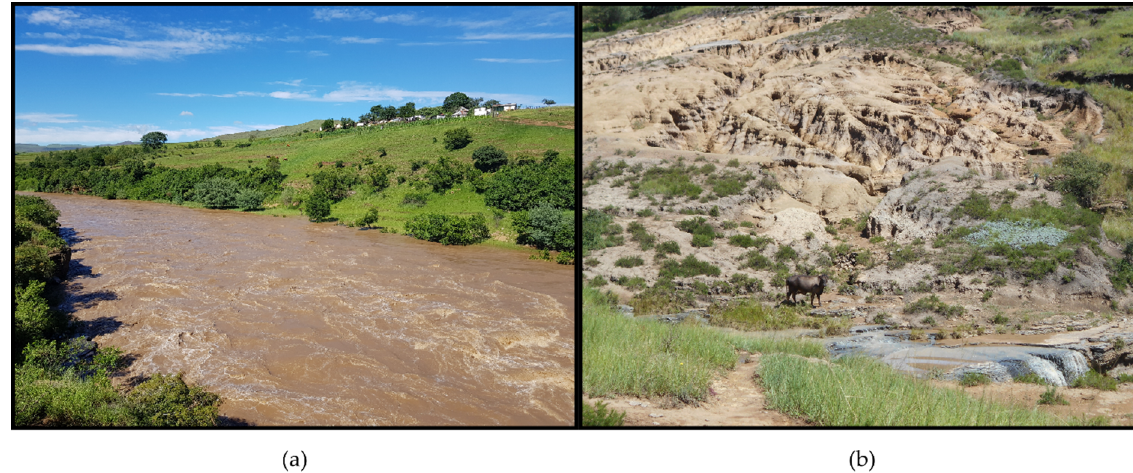
Figure 9. ( a ) Sediment transport in the Mkhomazi River during a flood’s peak. ( b ) Evidence of higher connectivity between gully systems and a secondary drainage network.